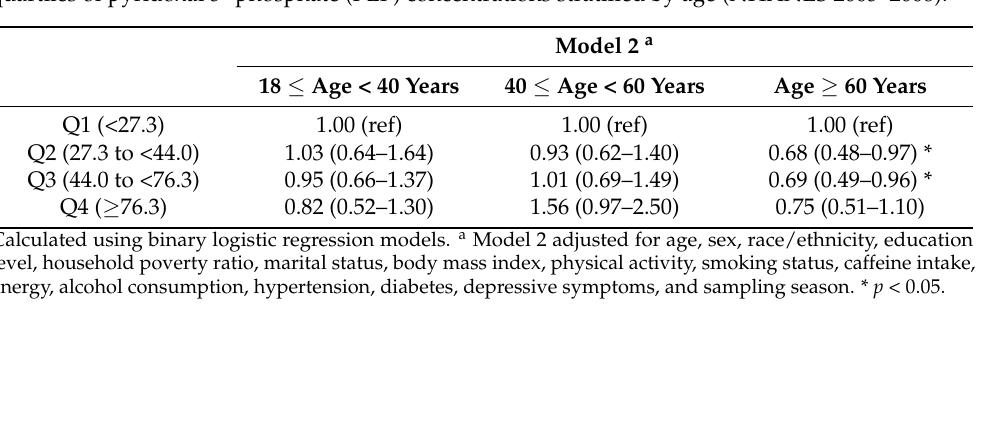
Table 4. Weighted odds ratios (95% confidence intervals) for having trouble falling asleep across quartiles of pyridoxal 5 (cid:48) -phosphate (PLP) concentrations stratified by age (NHANES